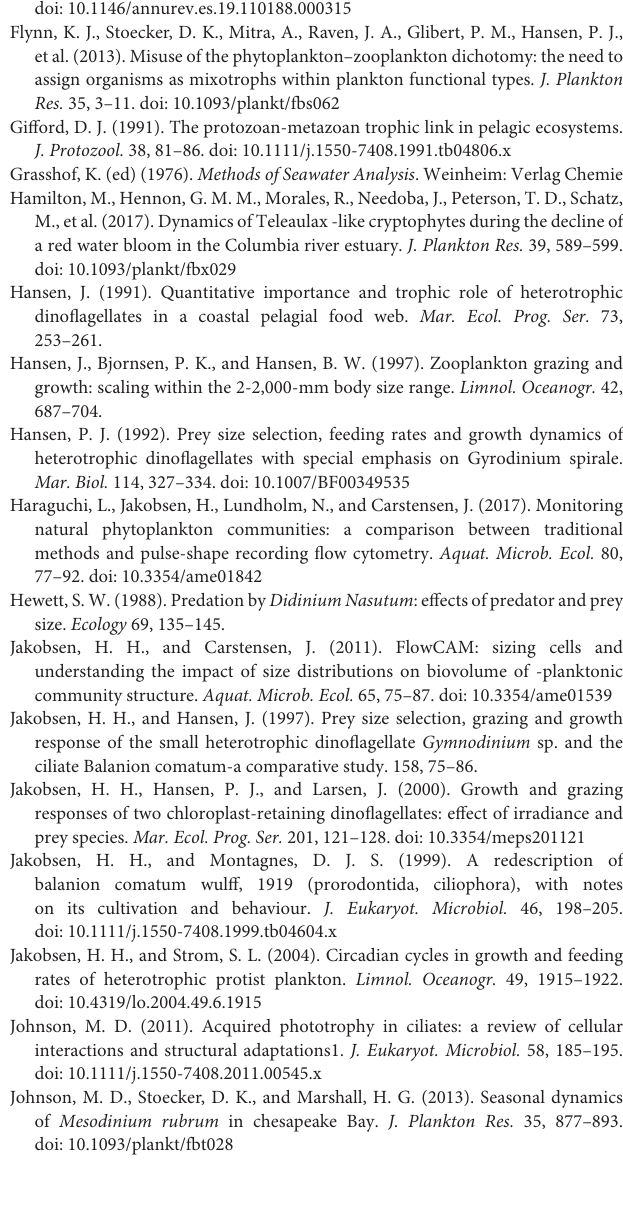
Figure S1 | Map showing the sampled station location (red star) at Roskilde Fjord